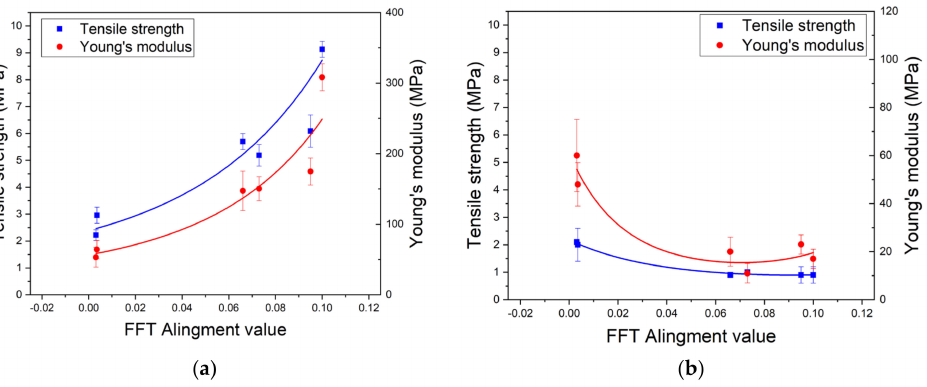
Figure 7. The dependence of mechanical properties on Fast Fourier Transformation (FFT) alignment value: ( a )—nanofibers oriented in a parallel direction; ( b )—nanofibers oriented in a perpendicular